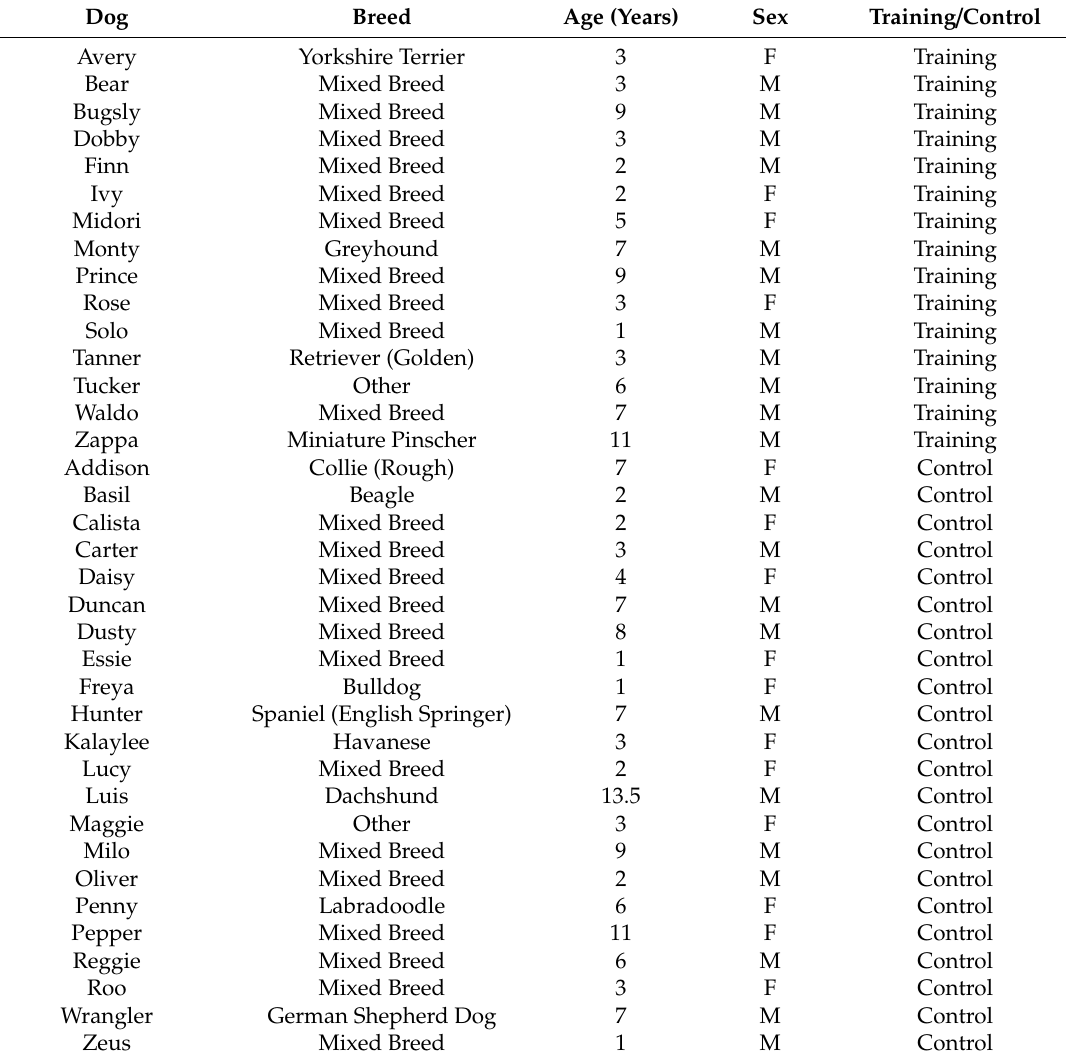
Table 1. Characteristics of dog participants (n =